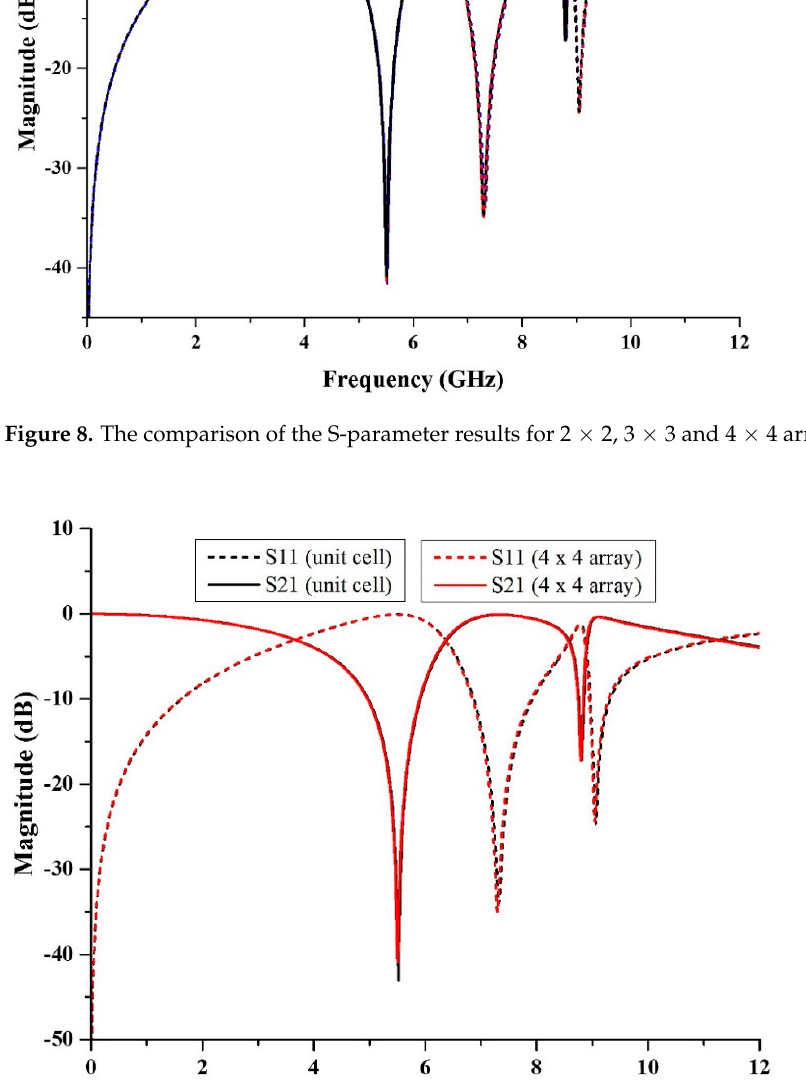
Figure 8. The comparison of the S-parameter results for 2 × 2, 3 × 3 and 4 × 4 arrays.